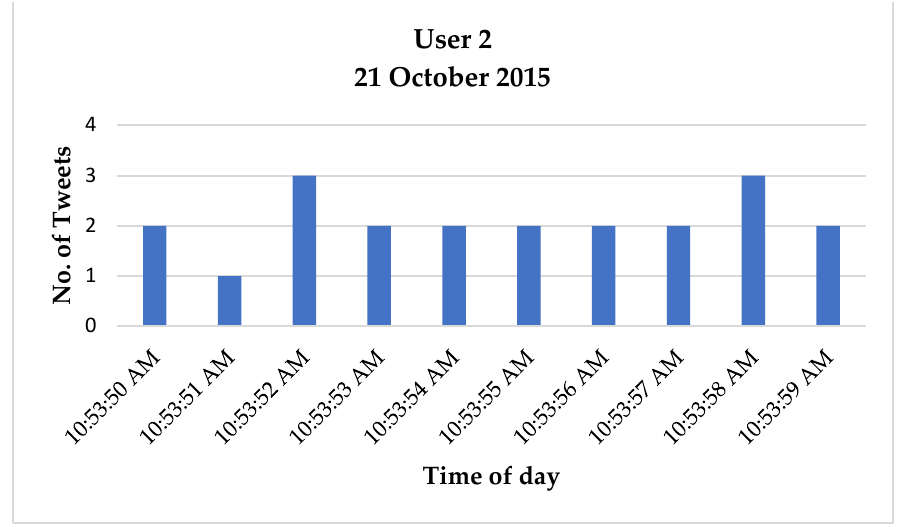
Figure 6. Volume of User 2’s Twitter posts in a ten-second period.